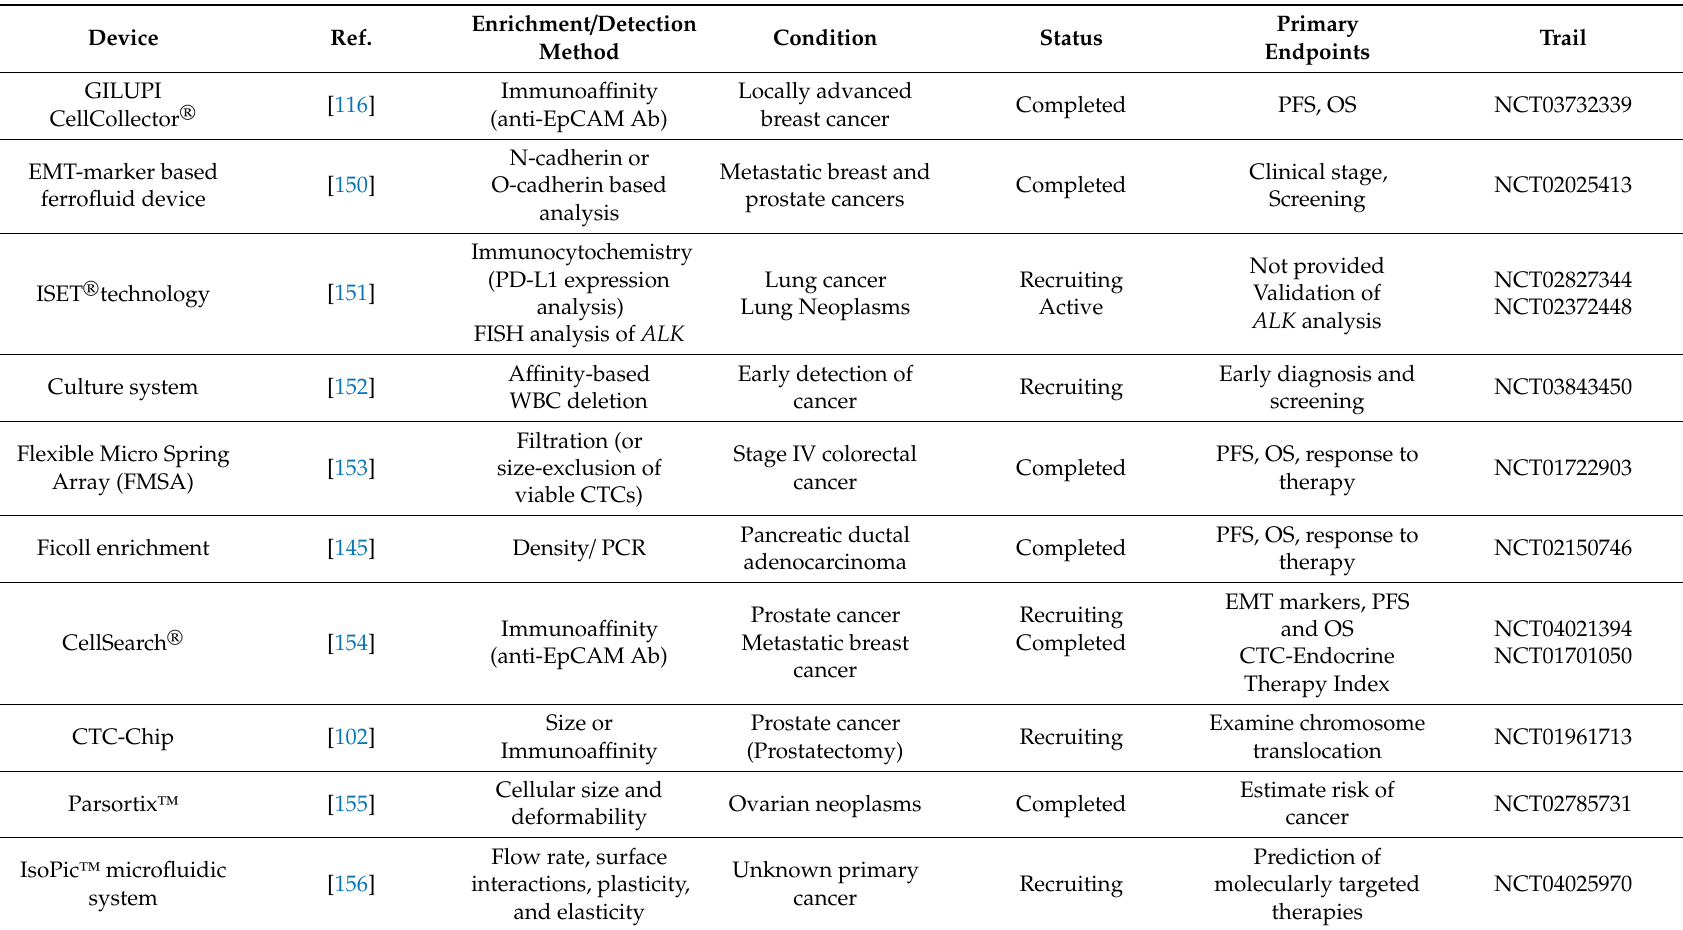
Table 2. Examples of clinical trials testing CTC-based enrichment